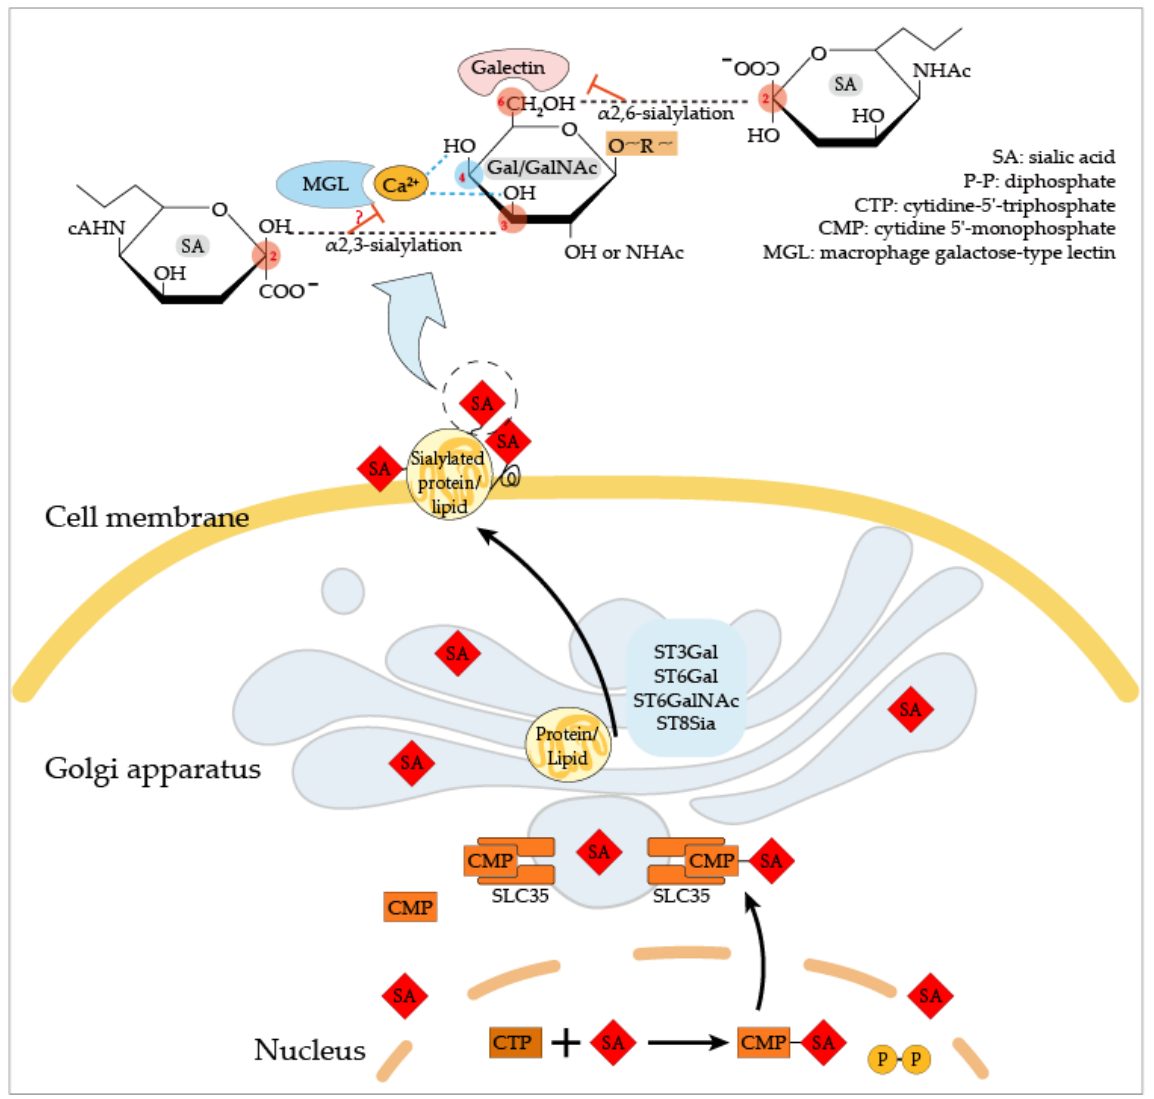
Figure 3. The structural basis and process of sialylation.